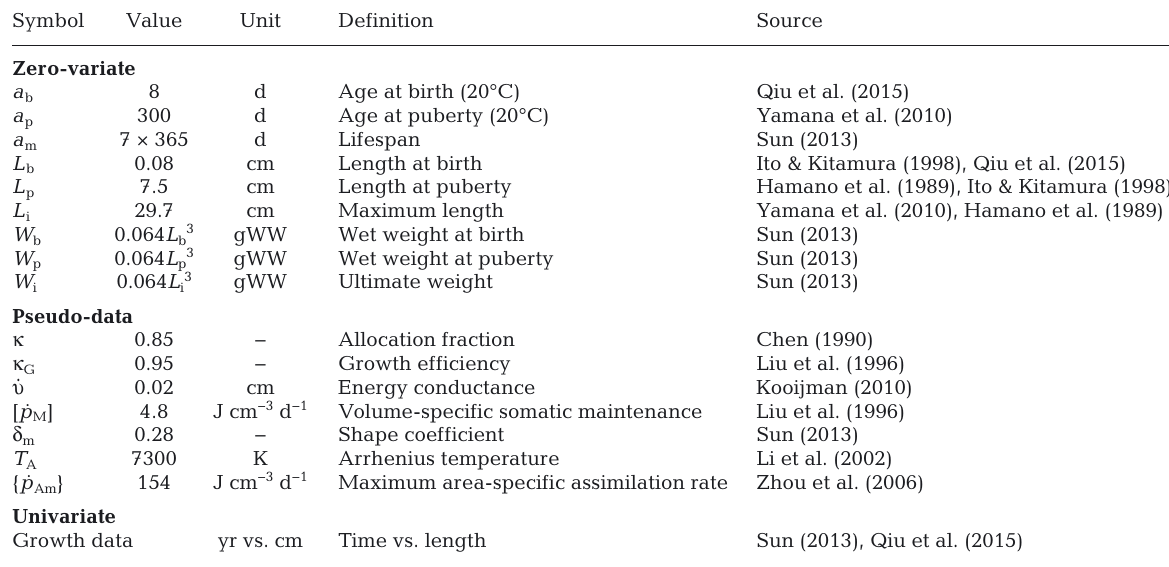
Table 1. Data used in parameter estimation procedure. gWW: grams of wet